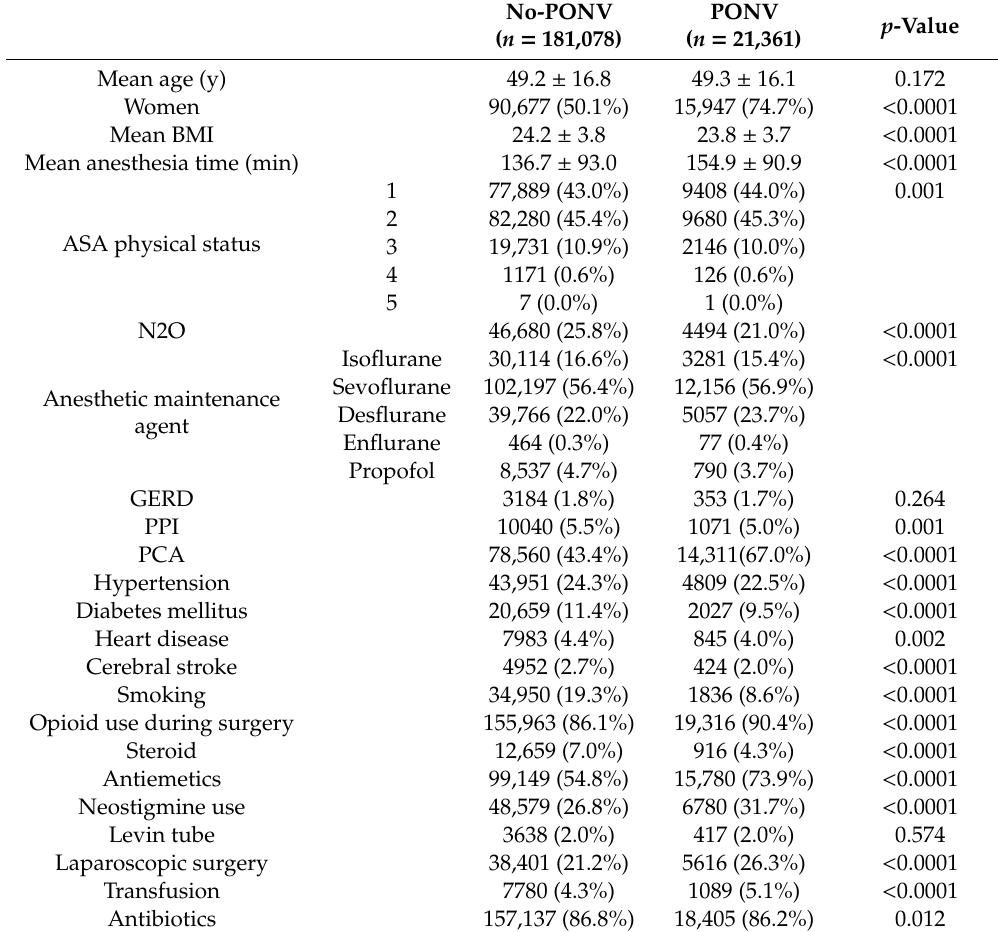
Table 1. Demographic characteristics and clinical data of patients undergoing general